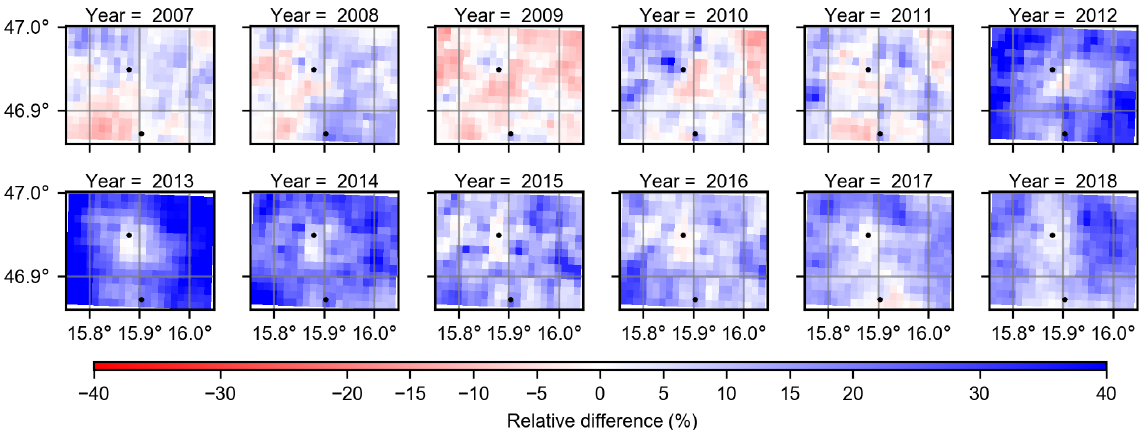
Figure 4. Annual relative difference between INCA and WegenerNet in each pixel. The black dots indicate the two ZAMG stations in the study